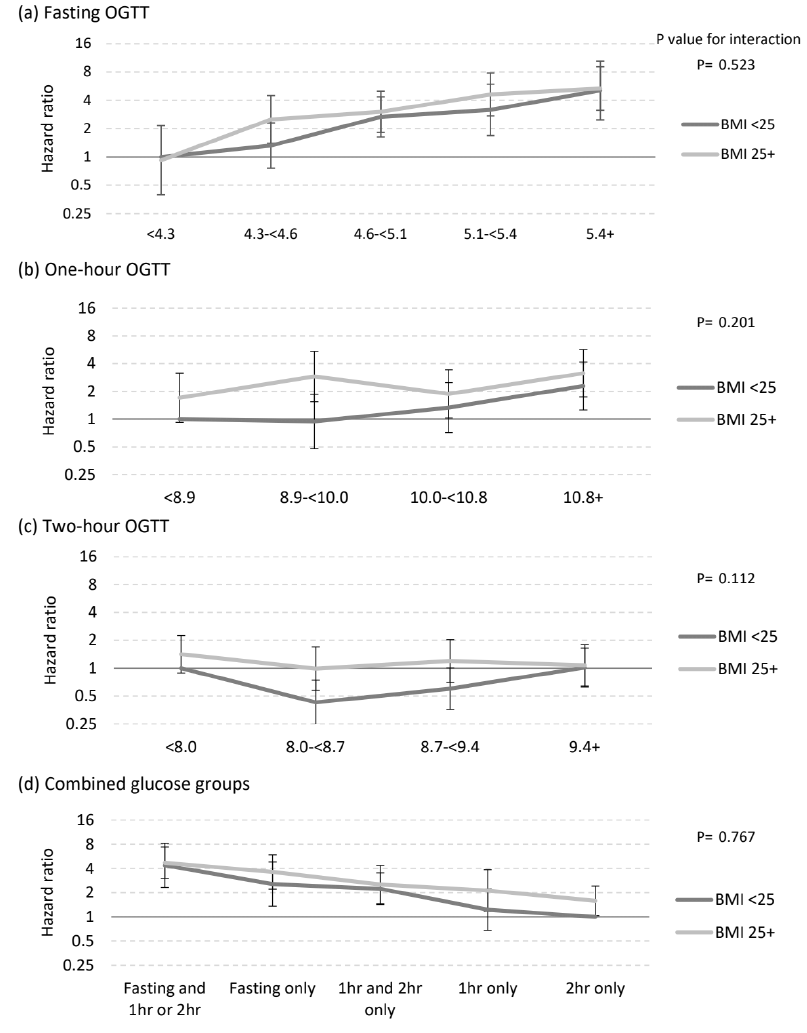
Figure 2. Adjusted hazard ratio for needing medication (metformin and/or insulin) by glucose results and BMI category for ( a ) fasting glucose reading on OGTT, ( b ) one hour glucose reading on OGTT, ( c ) 2 h glucose reading on OGTT, ( d ) combined glucose groups. Adjusted for ethnicity (Caucasian, South Asian, South-East Asian, Other), birth year (in categories), parity (1, 2, 3+), maternal age (centred continuous). OGTT, oral glucose tolerance test.